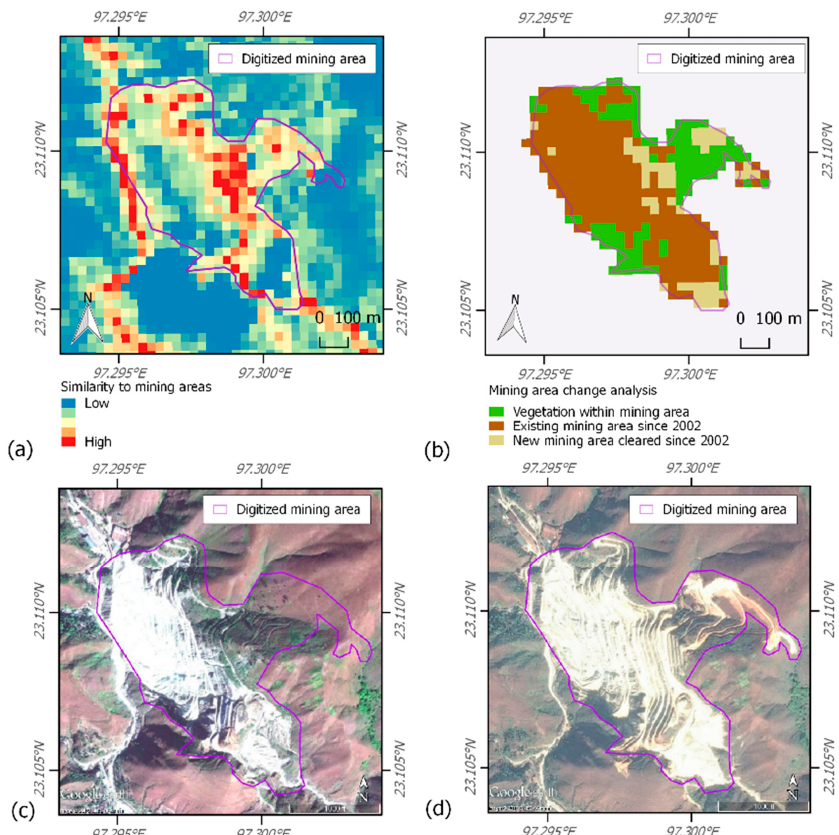
Figure 2. An example of mining area change at the Bawdwin mine in Namtu Township of Shan State. ( a ) Landsat-based potential mining raster layer identifying areas that are spectrally similar to known mine sites. This raster layer was used to guide the subsequent manual review of fine-resolution imagery; ( b ) Final raster layer output from the mining area change analysis, shown with the mining area boundary that was manually digitized; ( c ) Google Earth image from January 2010 (earliest available fine-resolution image). This imagery was not used in the analysis, but is included to illustrate mine area expansion; ( d ) Google Earth image from December 2013 (most recent fine-resolution image available), used to manually digitize the mining area boundary. Table 1. Features of mining areas that can be identified from fine-resolution satellite images. These features were used during manual digitizing to determine the weight of evidence for identifying a mining area (meaning no single feature or combination of features indicated a high-certainty mining area). Feature Indicating a Potential Mining Area